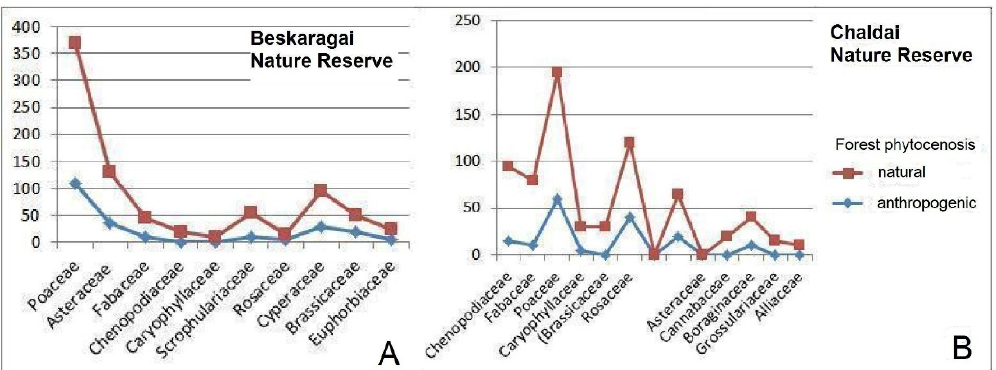
Figure 6. Plant species structure of the Beskaragai upland ( A ) and the Chaldai plain ( B ) pine forests.